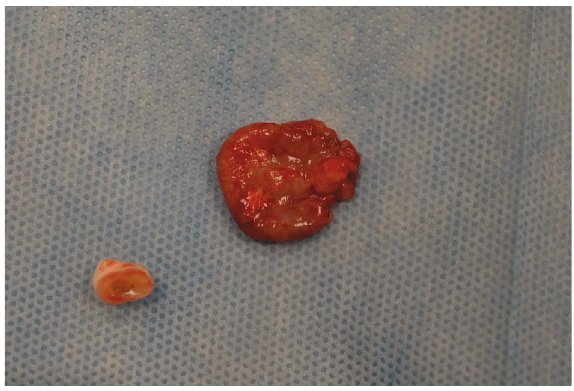
Figure 5: Cyst and tooth 15